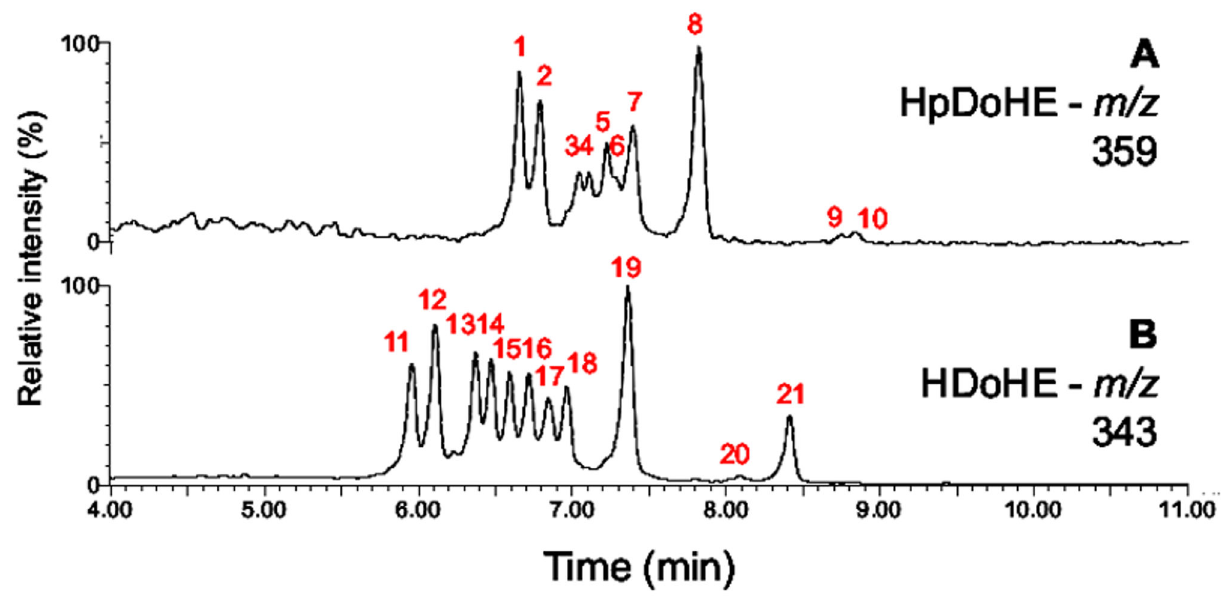
Figure 2. Analysis of a mixture of HpDoHE and HDOHE isomers by UPLC-MS. The HpDoHE and HDOHE isomers were detected through the selection of m/z at 359 (A) and 343 (B), respectively. The identities of the peaks numbered in red are shown in Tables 1 and 2 and Figure